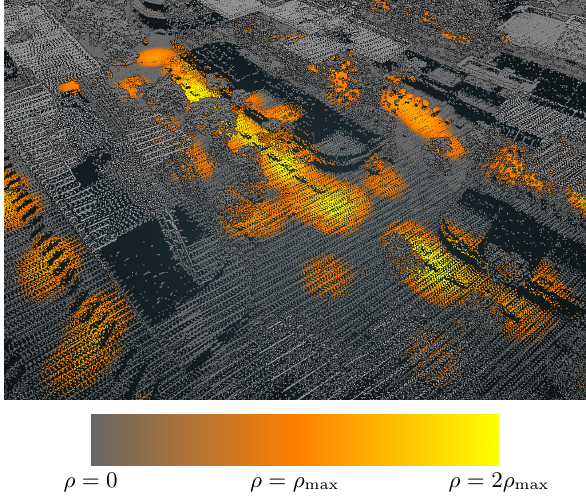
Figure 4. (Top) Egress behavioral data heatmap, with points shaded by behavioral event location density. (Bottom) Resulting color scale for vertex color c based on ρ when c max = rgb (1 . 0 , 0 . 5 , 0 . 0) and ρ was